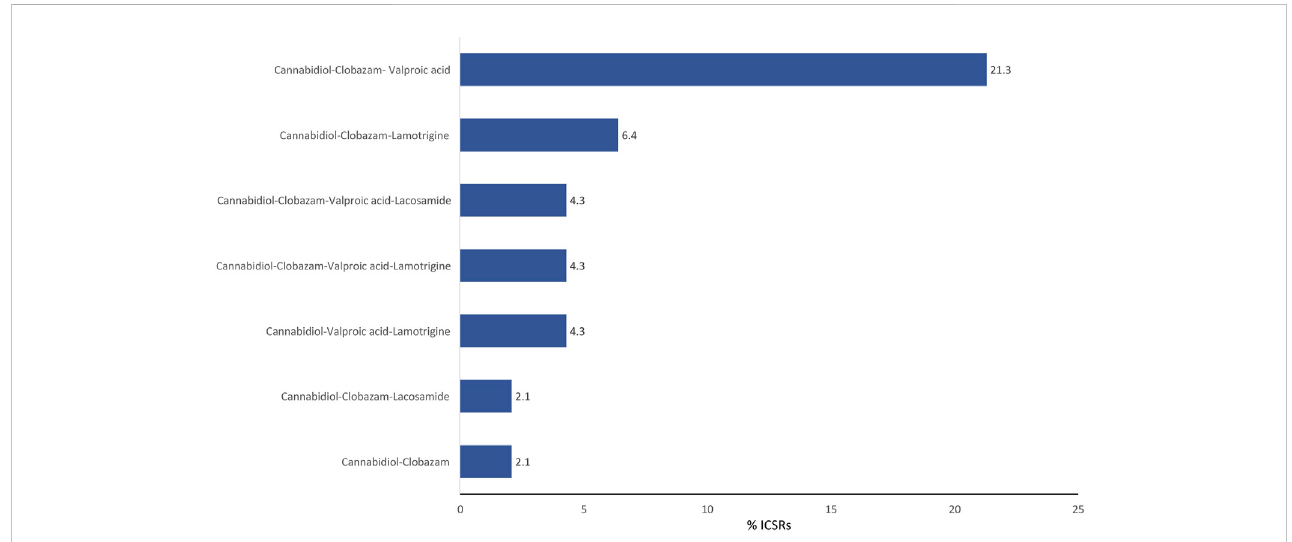
FIGURE 2 Combination of drugs prescribed with cannabidiol for epilepsy in the years 2019 – 2022 in serious cannabidiol-related individual case safety reports (ICSRs) in the EudraVigilance database. ICSRs = 47. The data are expressed as a percentage of the total number of serious ICSRs (N =